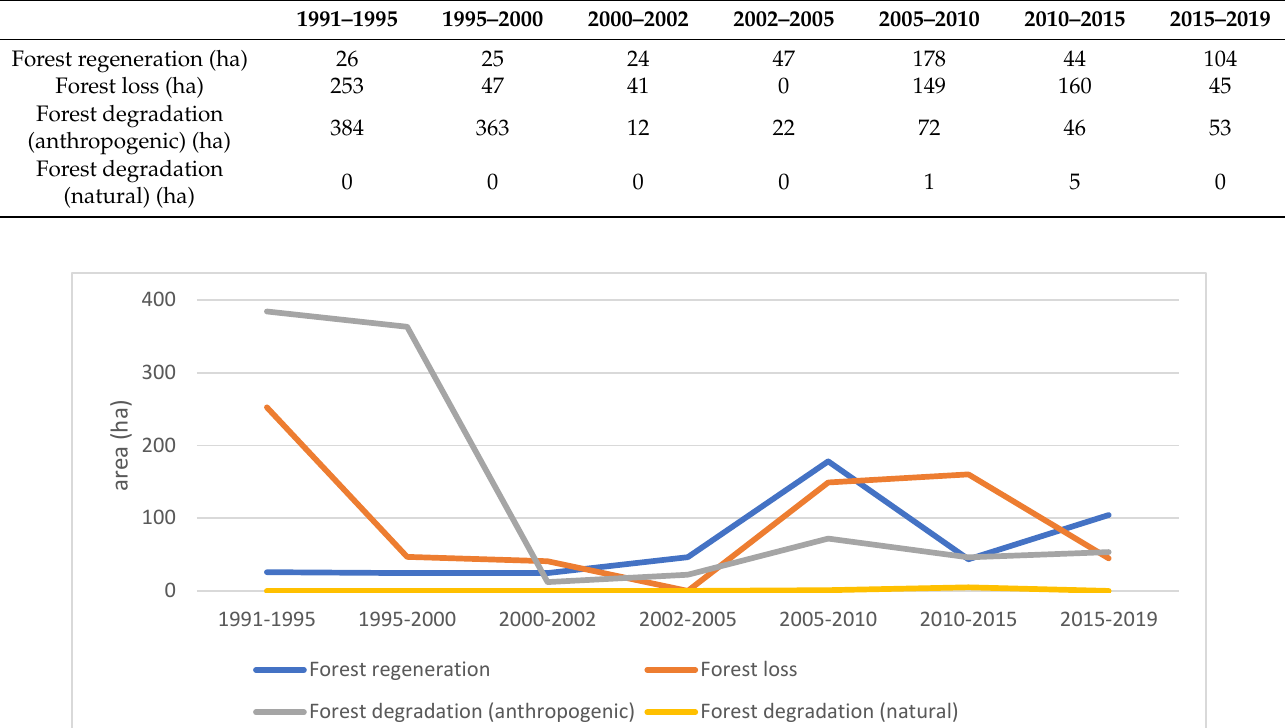
Figure 11 . Evolution of Forest Perturbation in hectares, over the 1991 to 2019 period .